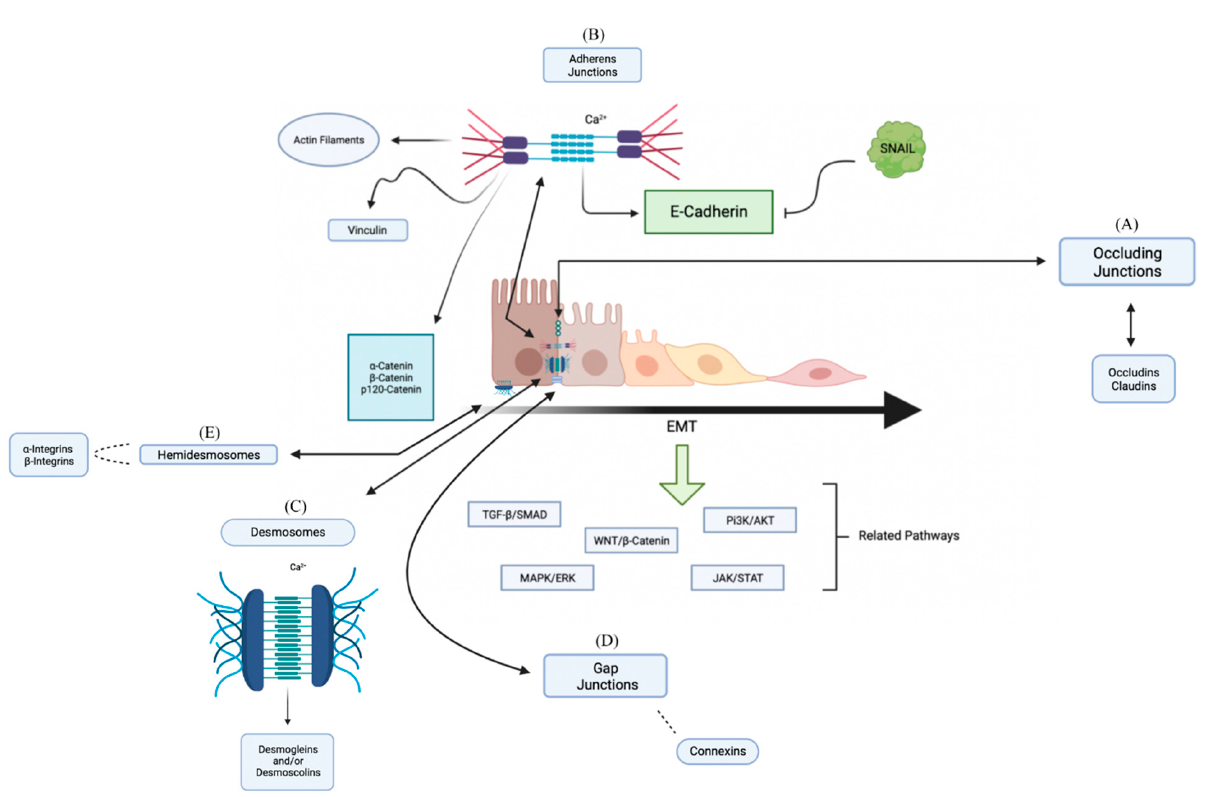
Figure 1. The descriptive diagram model of composition and interactions between proteins that are part of the cell union complex. ( A ) The Occlusion Junctions seal the spaces between epithelial cells, and it is of paramount importance in sealing the epithelial tissues to water molecules and ions, making the passive diffusion of ions impossible; here Occludins and Claudins act. ( B ) The Adherens Junctions connect the bundles of Actin Filaments of one cell with the bundles of another cell where the primary function is to promote adhesion between neighboring cells being crucial in tissue architecture; here Cadherins, α -Catenins, β -Catenins, p120-Catenin, and Vinculins acts. The regulation of the cell–cell adhesion complex is mediated by E-Cadherin and can favor the transformation of epithelial cells into mesenchymal cells after triggering EMT inducers in the various pathways involved; among those involved, the SNAIL protein helps to promote this process by blocking the E-Cadherin. ( C ) Desmosomes connect the Intermediate Filaments of one cell with those of the other cell, with the main aim of promoting intercellular adhesion, not interfering with other junctions; here Desmogleins, Desmocolins, Plakoglobin, Desmoplakin, and the Intermediate Filaments are involved. ( D ) The Gap Junctions allow the passage of water-soluble molecules from one cell to another; it is formed by six subunits of Connexins forming a hexagonal complex. ( E ) Hemidesmosomes anchor the cell’s Intermediate Filaments to the Extracellular Matrix—Cell/Matrix adhesion anchors the Actin Filaments of the cell to the Extracellular Matrix, connecting the Intermediate Filaments of the Cytoskeleton with the Extracellular Matrix; here α -Integrins and β -Integrins are